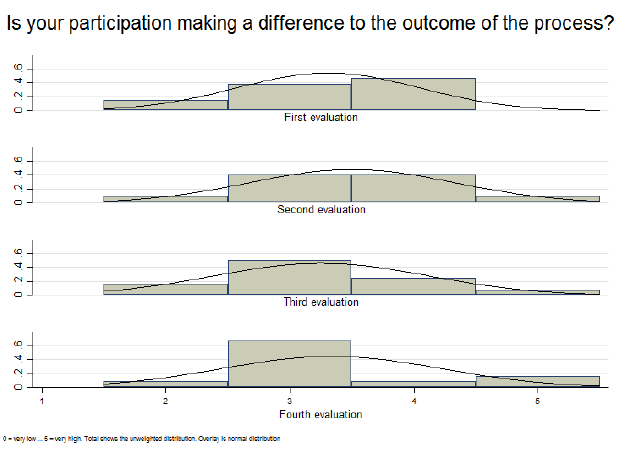
Figure A1.2 Results from the TANK process over time, “My participation is making a